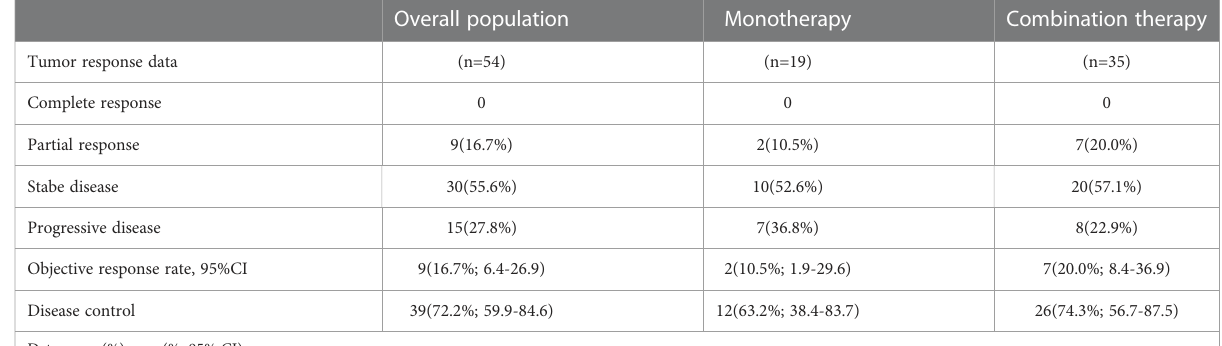
TABLE 3 Subgroup analysis of overall survival by monotherapy and combination